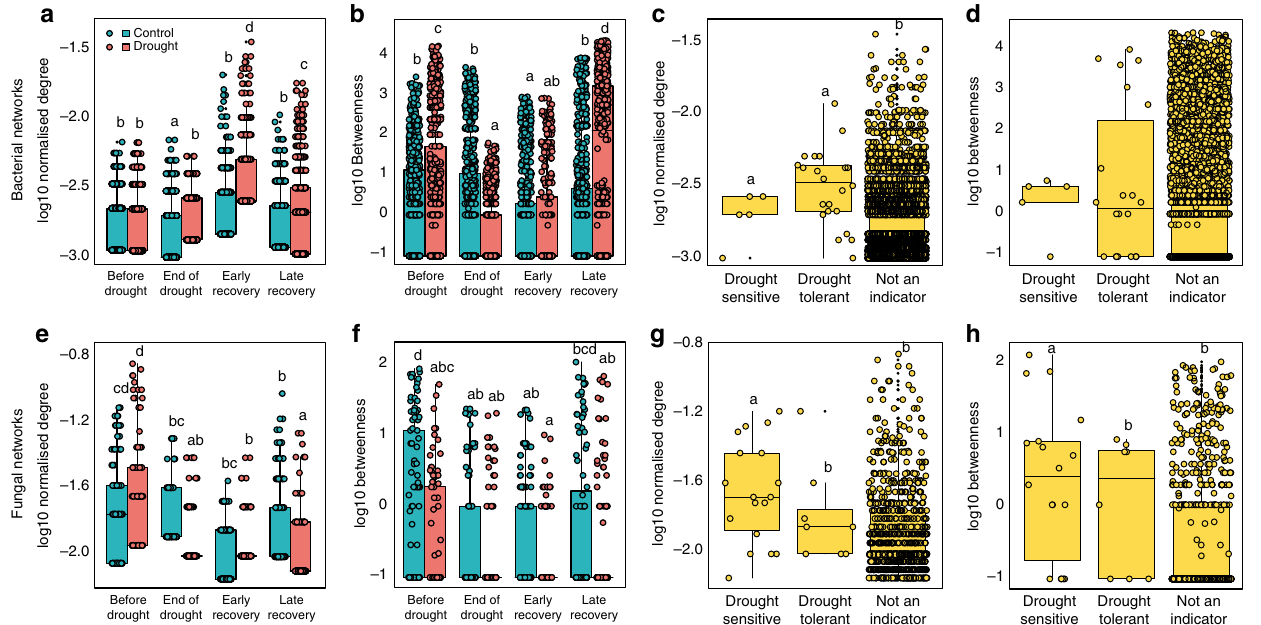
Fig. 5 Node connectedness and centrality of bacterial and fungal networks. In bacterial networks, drought increased connectedness (normalised degree) and centrality (betweenness) at post-drought samplings ( a , b Sampling × Drought interaction F 3,5973 = 67.3, P < 0.001 and F 3,5973 = 107.5, P < 0.001, respectively), while in fungal networks, drought did either not affect, or decrease these properties ( e , f Sampling × Drought interaction F 3,833 = 21.6, P < 0.001 and F 3,833 = 1.4, P = 0.234 for normalised degree and betweenness, respectively). In bacterial networks, the normalised degree of drought- sensitive and drought-tolerant indicator OTUs was higher than those of non-indicator OTUs ( c F 2,5977 = 12.5, P < 0.001), but betweenness was not affected ( d ). In fungal networks, drought-sensitive OTUs had a higher normalised degree and betweenness than non-indicator OTUs ( g , h F 2,834 = 10.8, P < 0.001 and F 2,834 = 11.6, P < 0.001, respectively). Lines in boxes represent median, top and bottom of boxes represent fi rst and third quartiles, and whiskers represent 1.5 interquartile range; dots represent single observations. Boxes with the same lower-case letters are not statistically